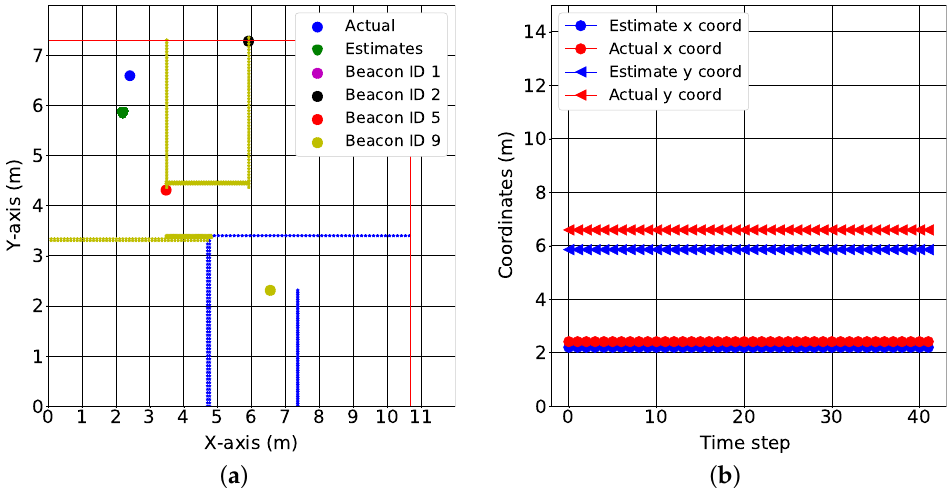
Figure 17. Testing in a bedroom. ( a ) Floor plan view, and ( b ) location estimates over